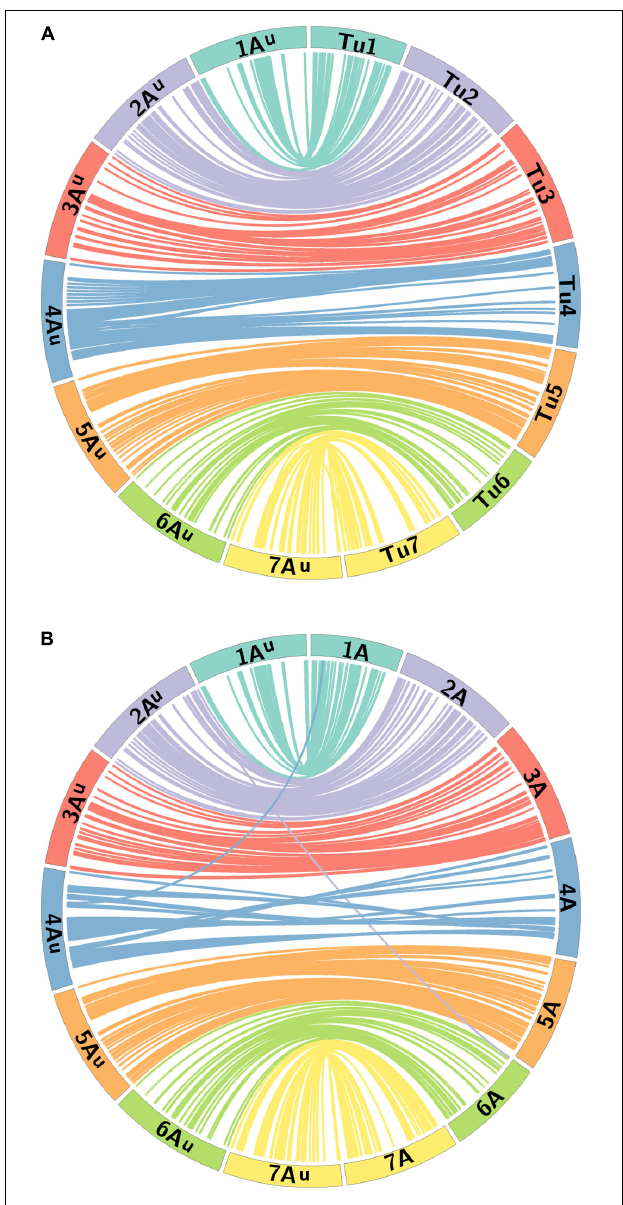
FIGURE 5 | Comparative analysis between the A u genome loci on the genetic map of T. urartu and their physical positions on (A) the Tu chromosomes and (B) the A genome of wheat. Homeologous chromosomes from 7 LGs between T. urartu and wheat are displayed as ideograms of the same color. Lines connect genetic map positions of markers in the A u genome (left of plot) to their physical map positions (right of plot) on the (A) Tu chromosomes and (B) the A genome of wheat. Lines joining A u and wheat A chromosomes with the same color as the ideograms indicate synteny through mapping in homeologous LGs. Lines between the A u and the wheat A genome that end in a different colored ideogram in the wheat genome point to mapping in non-homoeologous